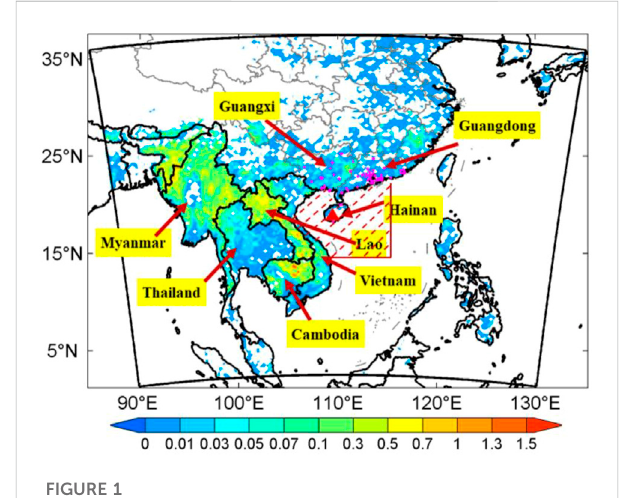
FIGURE 1 Model domain, period mean (December 2020 to April